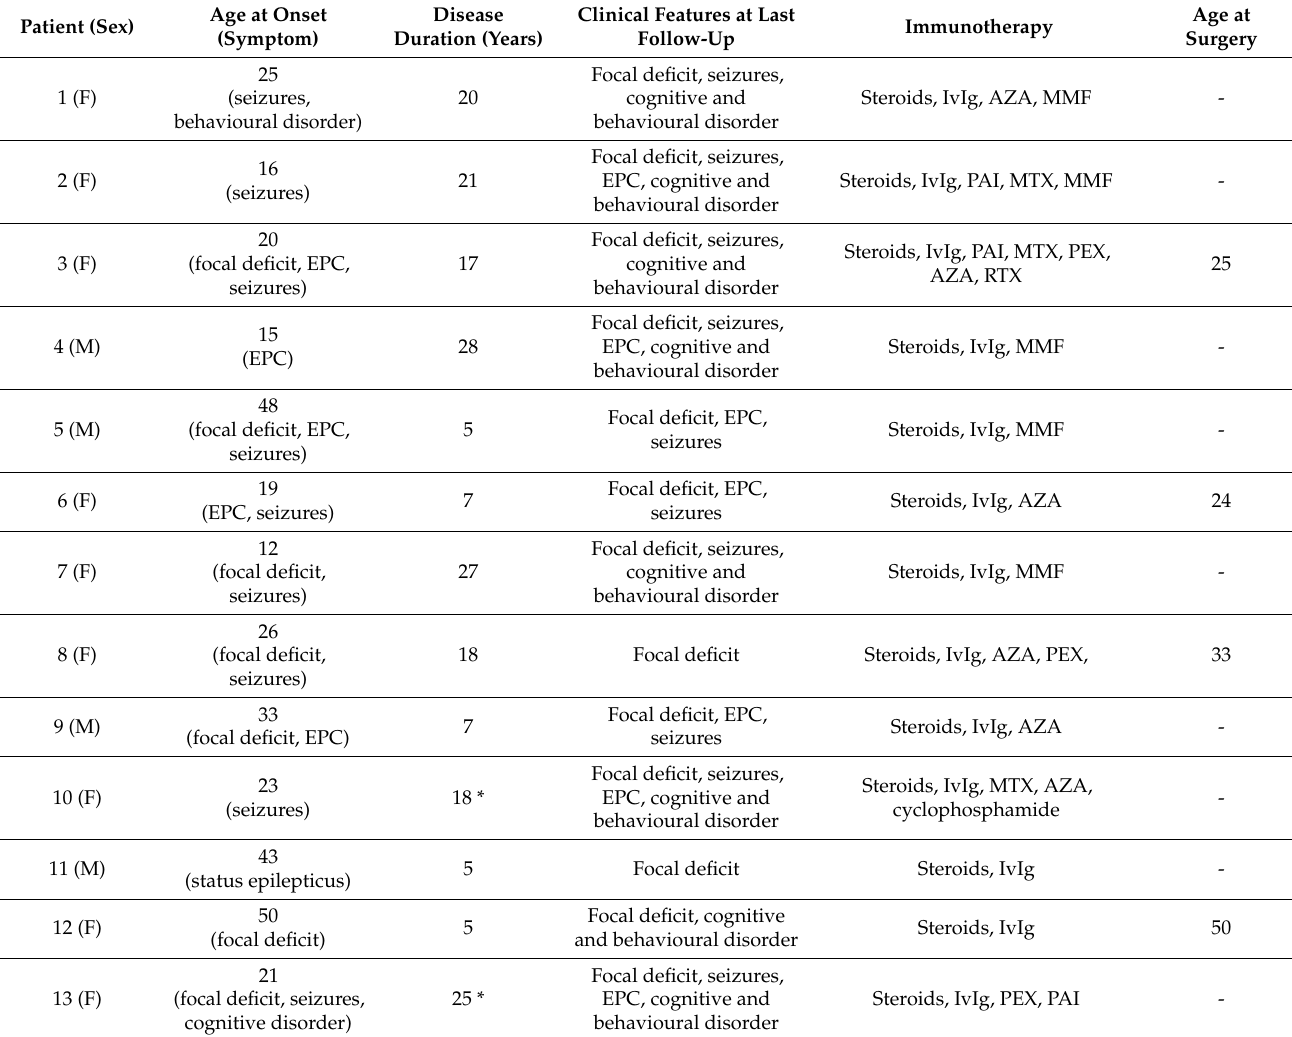
Table 1. Clinical characteristics of the